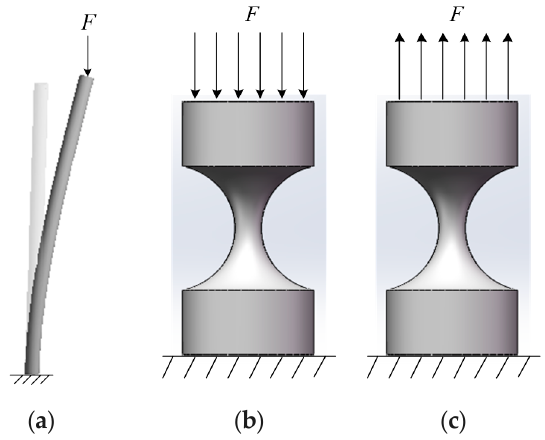
Figure 3. Buckling phenomenon of the slender rod: ( a ) the slender rod buckling phenomenon; ( b ) pressure on an RCCS flexural joints and ( c ) pull on RCCS flexural joints.